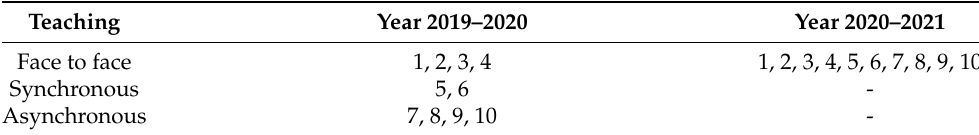
Table 2. Distribution of the topics of MP2. Teaching